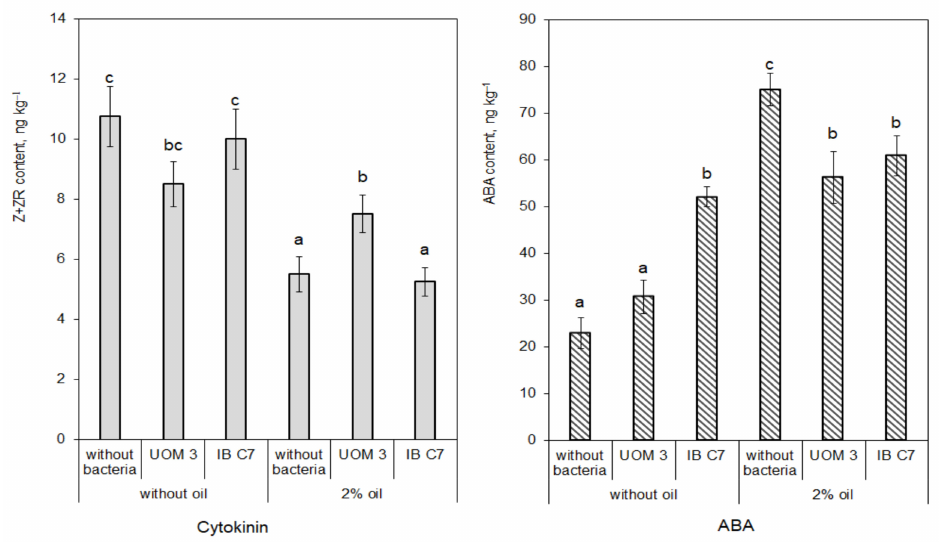
Figure 3. Cytokinin (Z+ZR) and ABA content pots planted with barley, ng kg − 1 of sand. UOM 3 and IB C7—treatments with introduction of Enterobacter sp. UOM 3 and P. hunanensis IB C7, respectively. Statistically different means for each hormone (n = 9) are marked with different letters ( p ≤ 0.05).